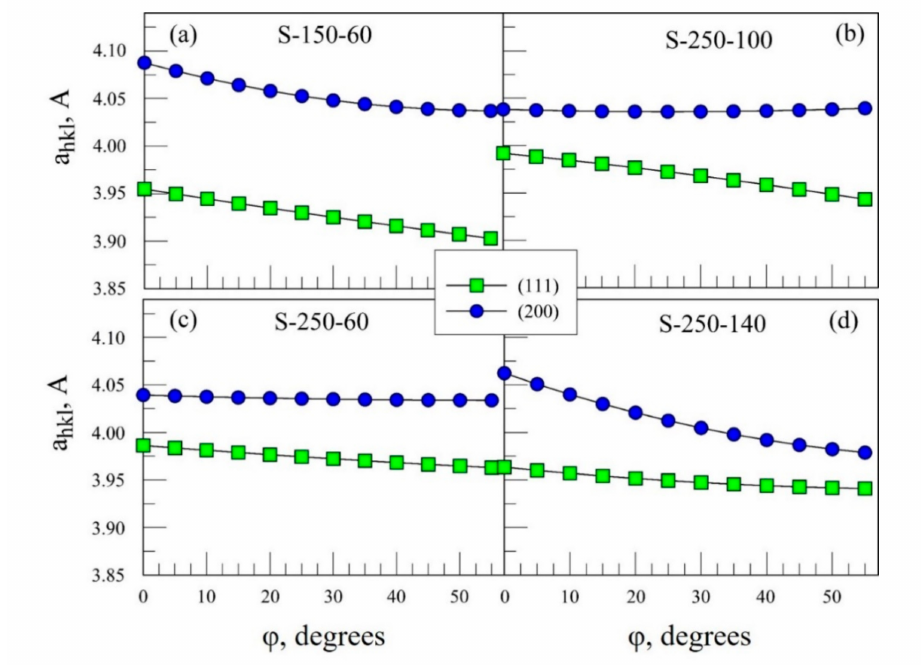
Figure 6. Lattice constant values as calculated from the positions of the (111) and (200) peaks, shown for four di ff erent deposition conditions ( a – d ). The lattice constants shown here were calculated based on the assumption of a cubic structure. The values are shown as a function of ϕ ; at ϕ = 0 the [002] direction is parallel to the surface plane